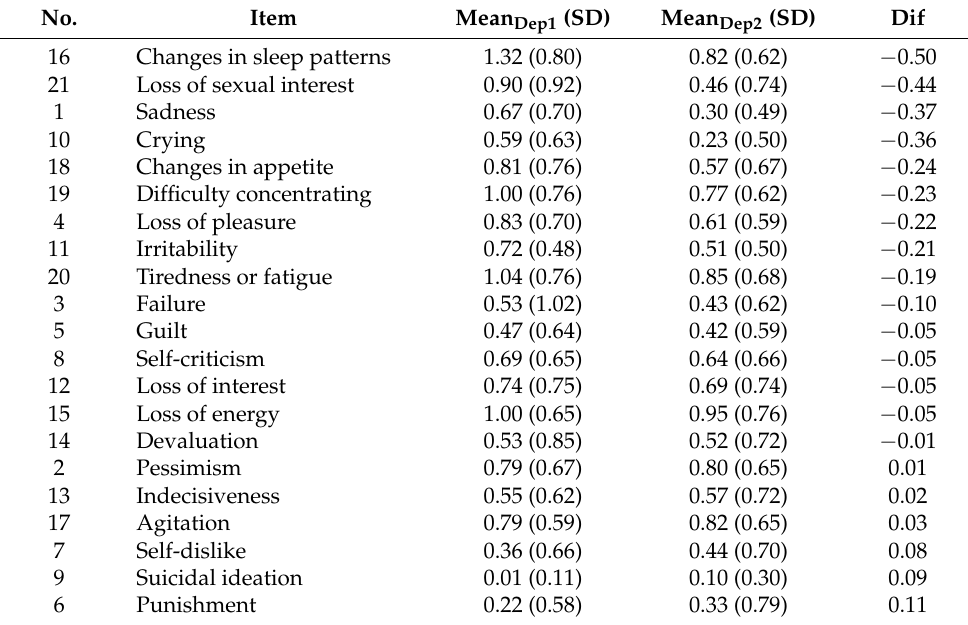
Table 7. Difference in means of BDI-II scores, before (Dep1) and after (Dep2). No.